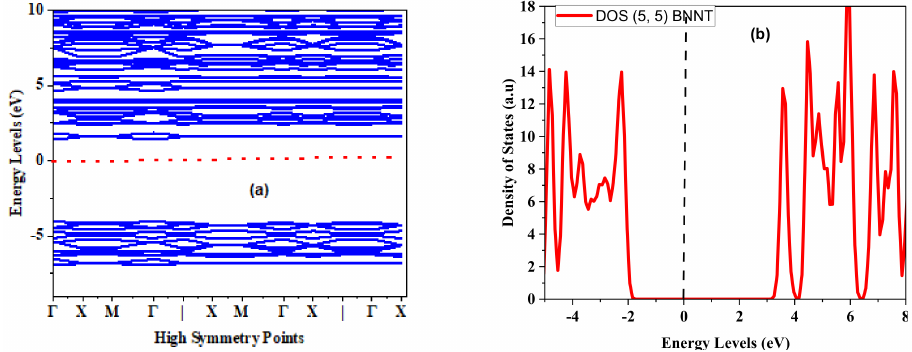
Figure 1. ( a ) The electronic bands and ( b ) density of the states of (5, 5) SWBNNTs.